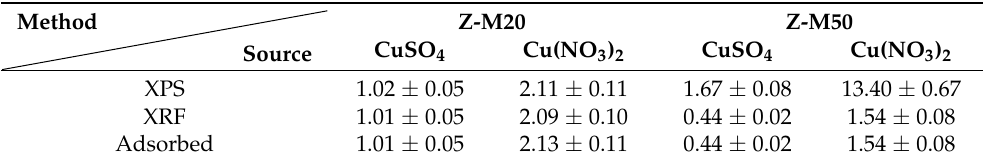
Table 4. A comparison of Cu content in mg · g − 1 ± standard deviation.